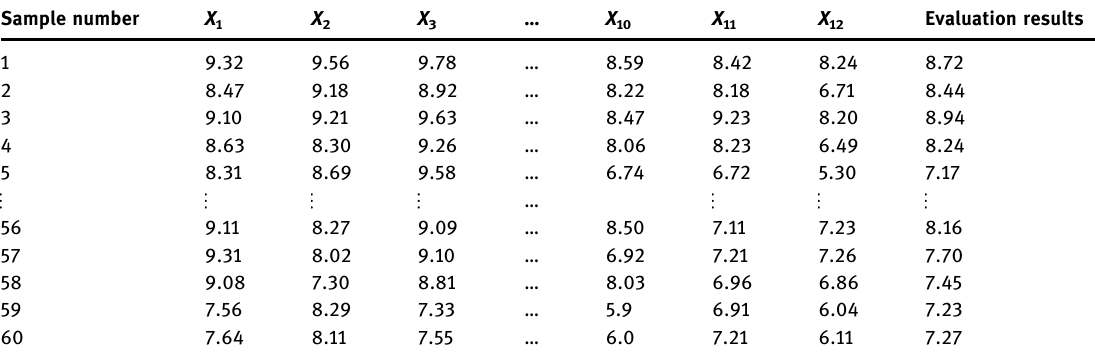
Table 2: Original data of students ’ English writing evaluation Sample